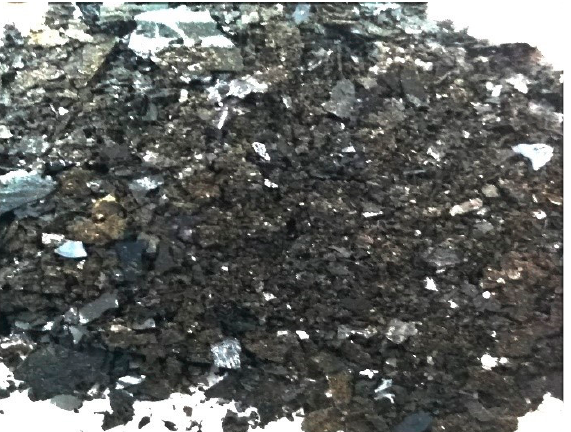
Figure 1. Black and shiny appearance of the asphaltene extracted from thermally treated COTBS.